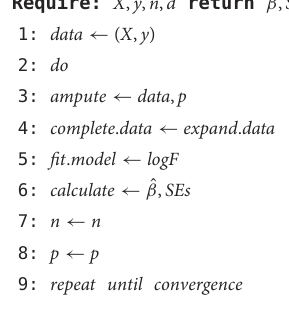
Algorithm 1. Validation algorithm for the LogF